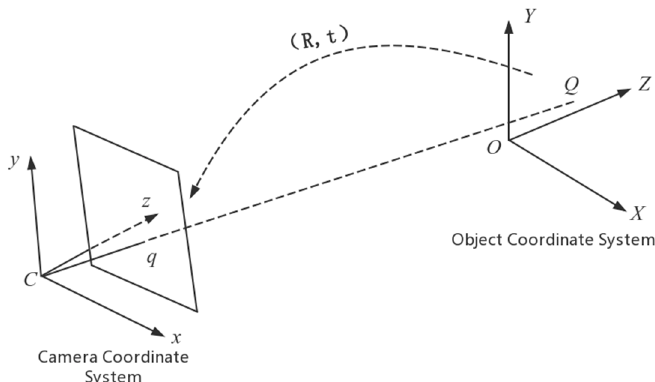
Figure 9. The translation and rotation relationship of the object coordinate system and the camera coordinate system.